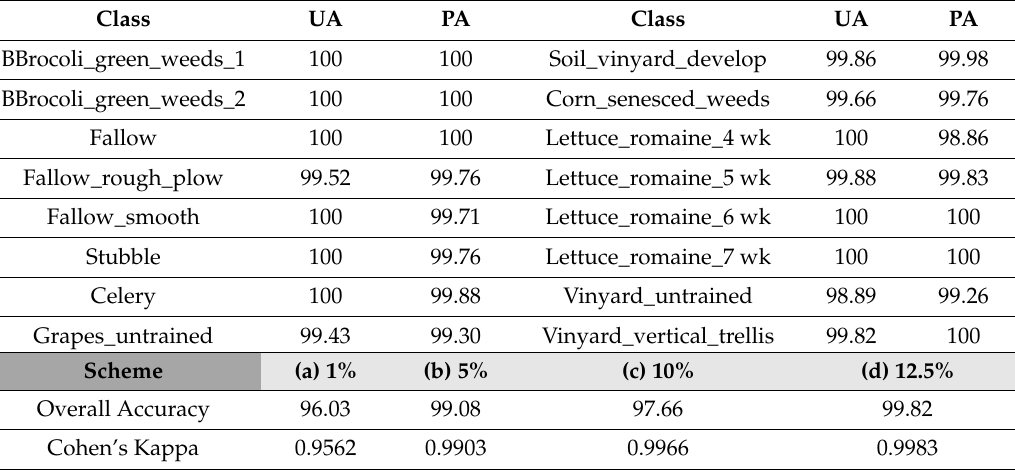
Table 5. User’s and Producer’s accuracy results (using 10% of the available training sample for the dataset), Overall accuracy and Cohen’s Kappa of the HDCA with different schemes on the Salinas dataset.